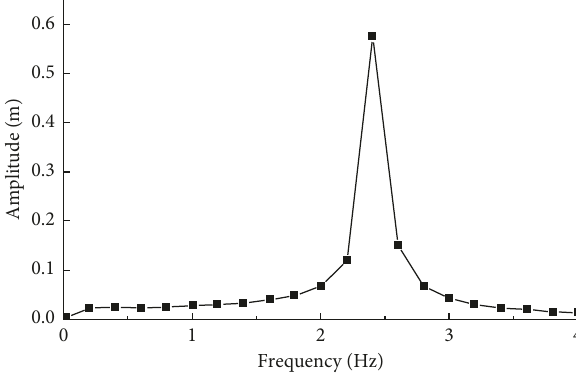
Figure 12: Buffering device amplitude-frequency